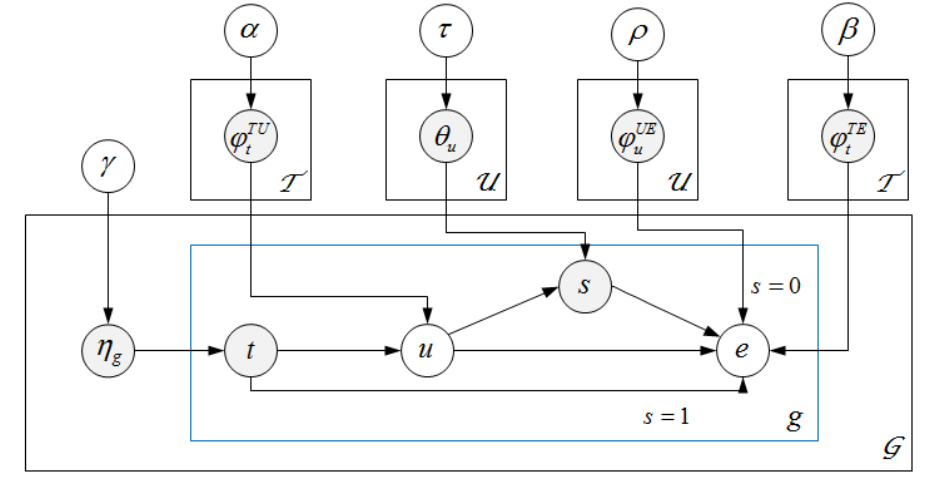
Figure 6. Graphical Model of